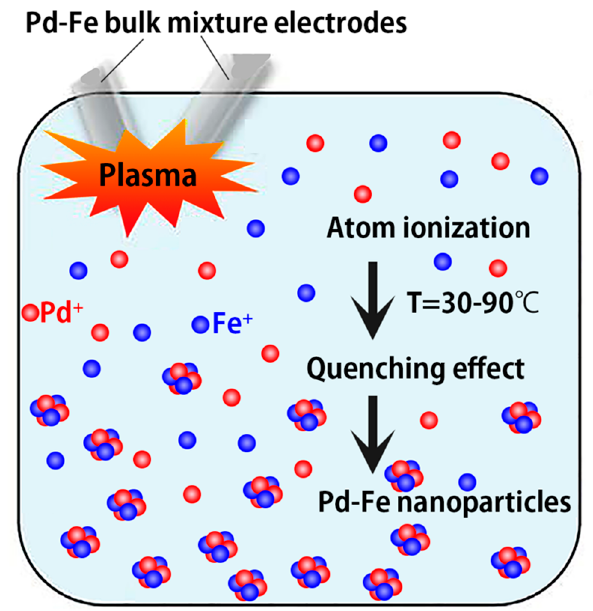
Figure 11. Optical emission spectrum from pulsed plasma in ethanol solution with Pd-Fe electrodes.